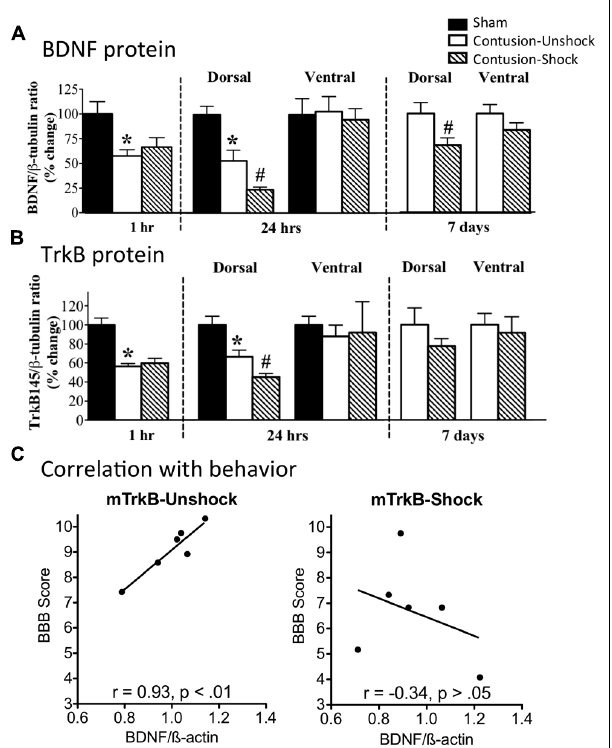
FIGURE 8 | Impact ofVIS on BDNF andTrkB expression in contused rats. (A) Rats received a moderate contusion injury or a sham surgery.The next day, contused rats receivedVIS (Contused-Shock) or nothing (Contused-Unshock). BDNF protein was assayed 1 h, 24 h, and 7 days after treatment. A contusion injury produced a significant decrease (*) in BDNF expression at 1 and 24 h (25 and 48 h after surgery). Shock treatment further down-regulated BDNF expression (#) at 24 h and 7 days. (B) TrkB protein expression was also down regulated by a contusion injury at 1 and 24 h (*). Shock treatment produced a further decrease at 24 h (#). (C) Locomotor performance on days 2–7 was highly correlated with mTRKB expression in untreated (Unshock) contused rats (left panel), but not in rats that received shock (right panel). Adapted from Garraway etal.